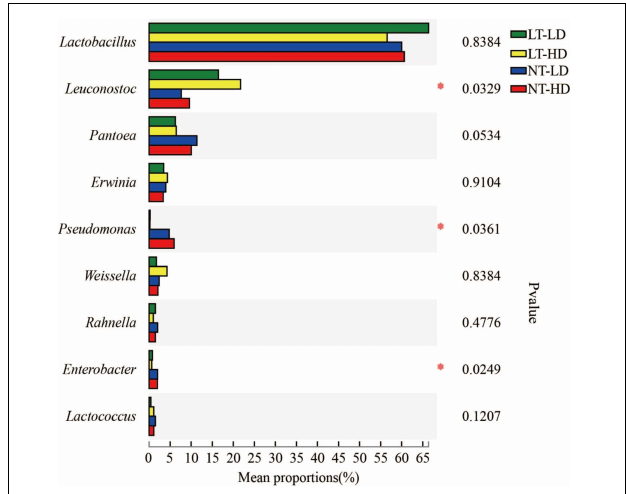
FIGURE 3 | Difference in bacterial community (genus level) of sorghum-sudangrass silage ( n = 3). LT, storage temperature at 10 ◦ C; NT, storage temperature at 25 ◦ C; LD, ensiling density at 550 kg/m 3 ; HD, ensiling density at 650 kg/m 3 . ∗ p < 0.05.